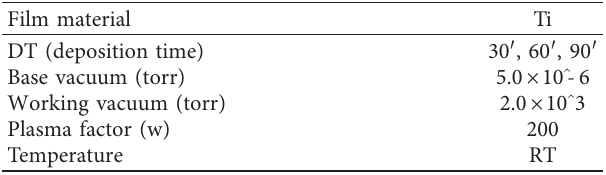
Table 2: Sputtering conditions for thin film deposition.